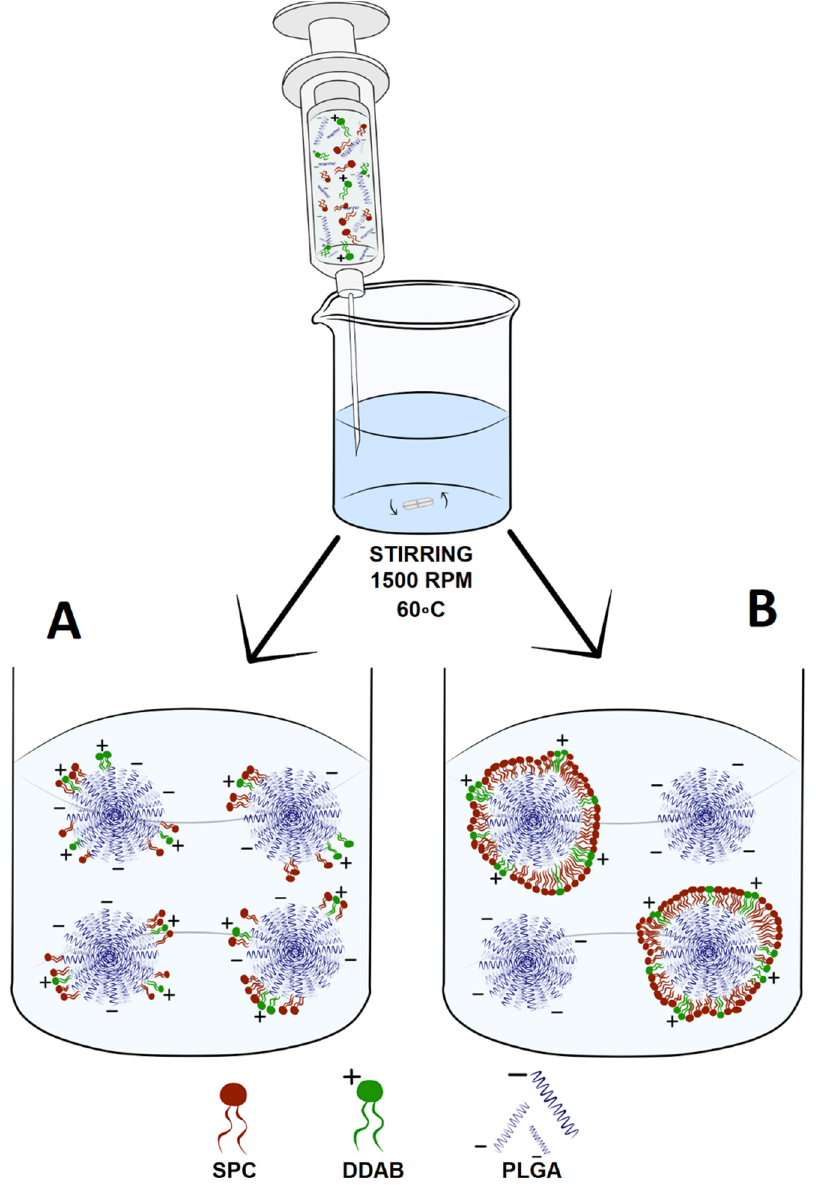
Figure 20. Proposed mechanism of PLGA coating with positively charged lipid layers according to zeta potential measurements for the 0 mV point, where ( A ) shows a variant with the coating of every PLGA particle equally with fractions of cationic lipids to full coating at the point of saturation, where a zeta potential plateau is achieved, and ( B ) shows a variant with the sequential full coating of every single PLGA particle with an increasing amount of lipids used.